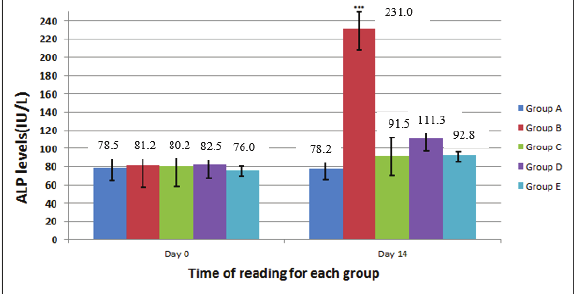
Fig-3: Effect of Ajwa date on ALP (mean ± SD) of ATT induced hepatotoxic rabbits (n=6) Group A: Normal Control, Group B: Anti-tuberculous drugs (ATT), Group C: ATT + Whole Ajwa Date, Group D: ATT + Ajwa Date Flesh, Group E: ATT + Ajwa Date Seed Powder